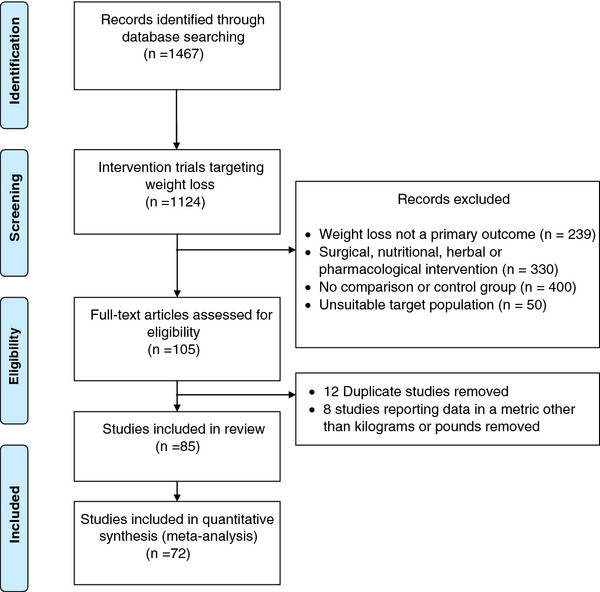
 Flow diagram of studies included in the review.